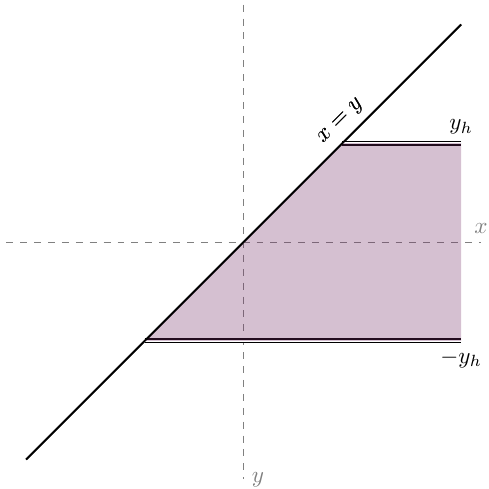
Figure 25 . Coordinate ranges for the Class III